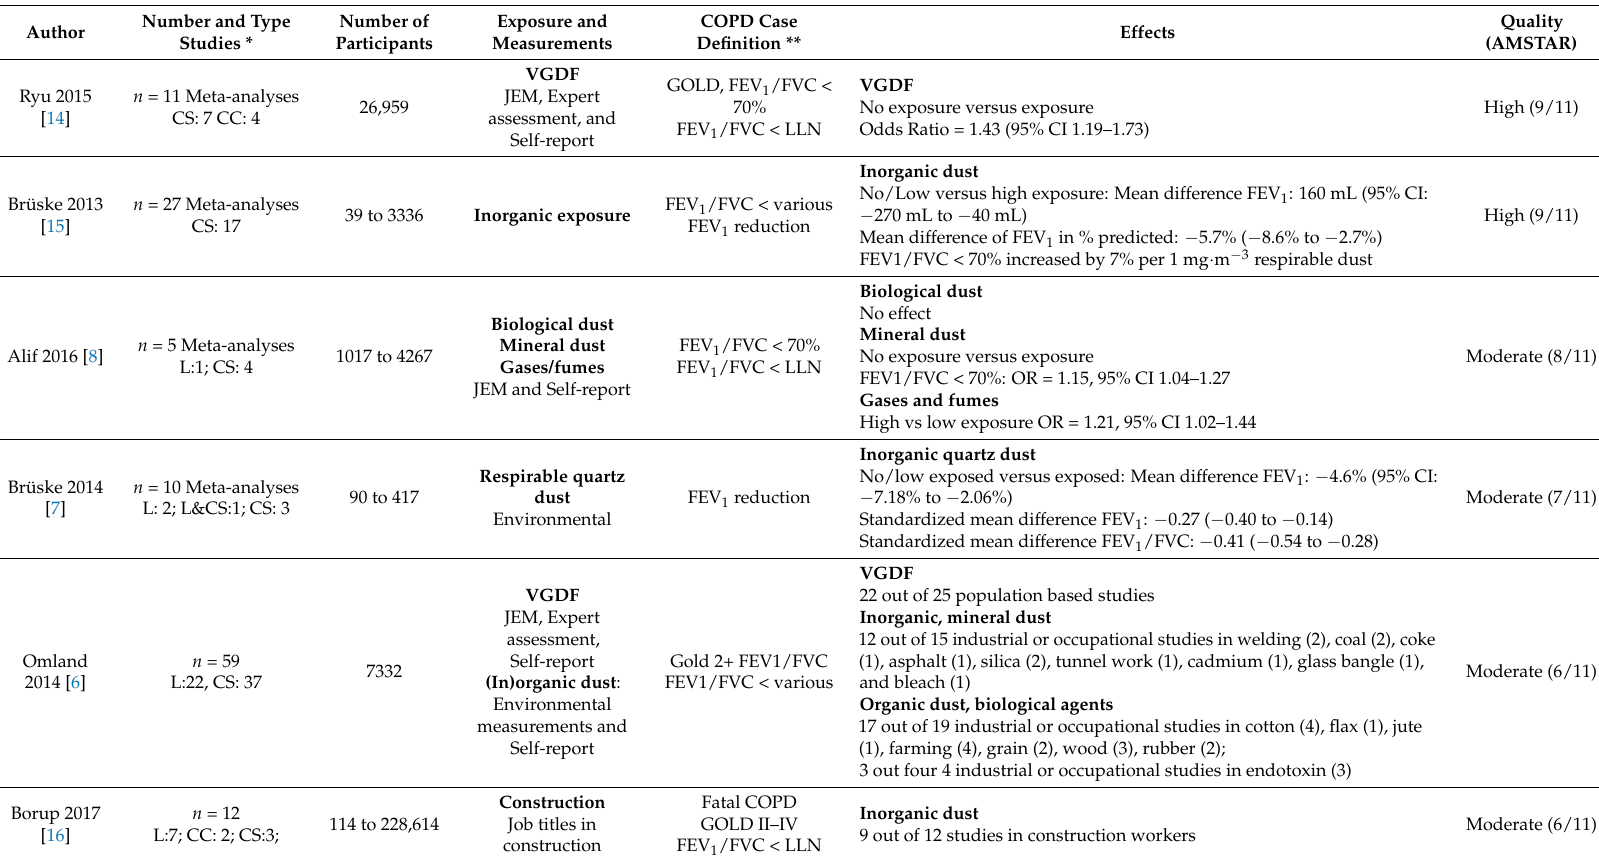
Table 1. Summary of findings from systematic reviews for associations between work and chronic obstructive pulmonary disease